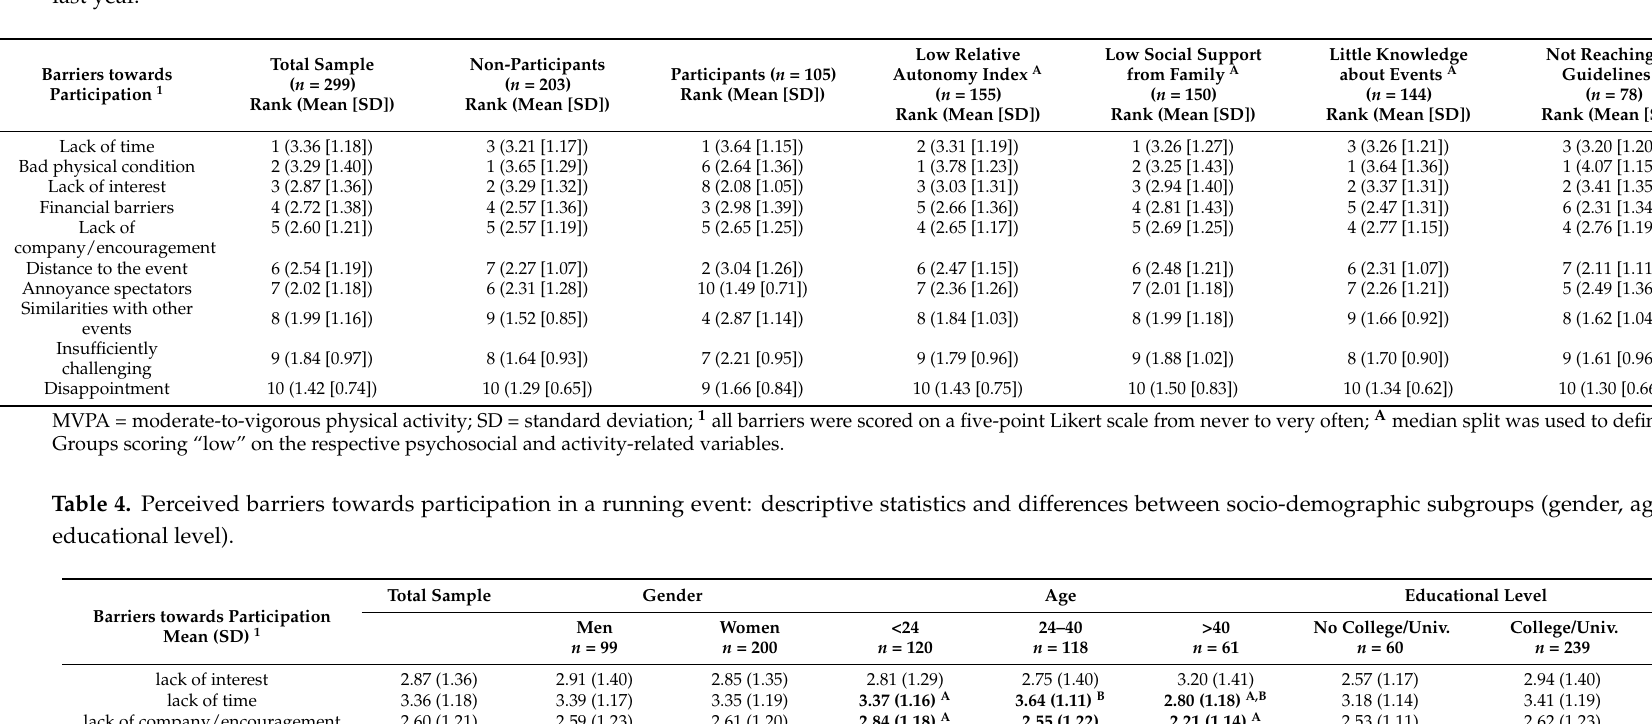
Table 3. Ranking of perceived barriers towards participation in the total sample and in adults who are less likely to have participated in a running event during the last year.